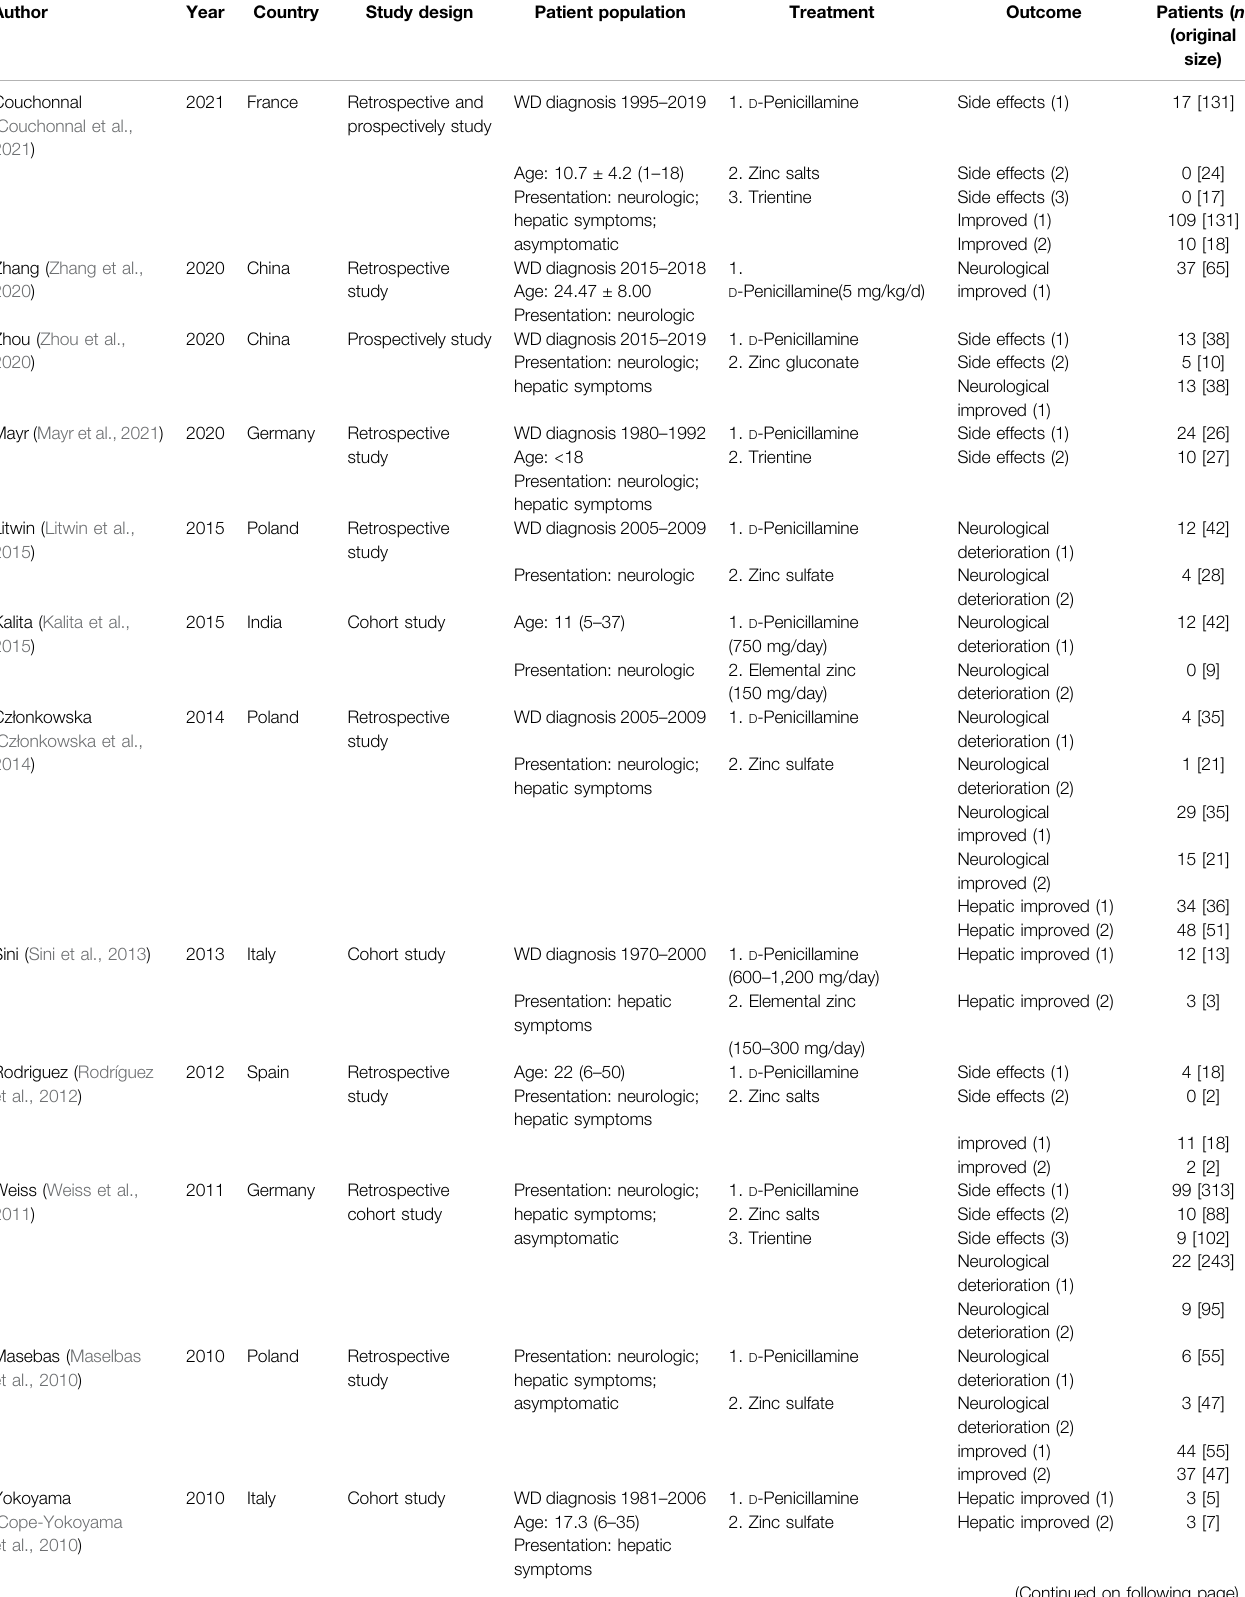
TABLE 1 | The characteristics of the included